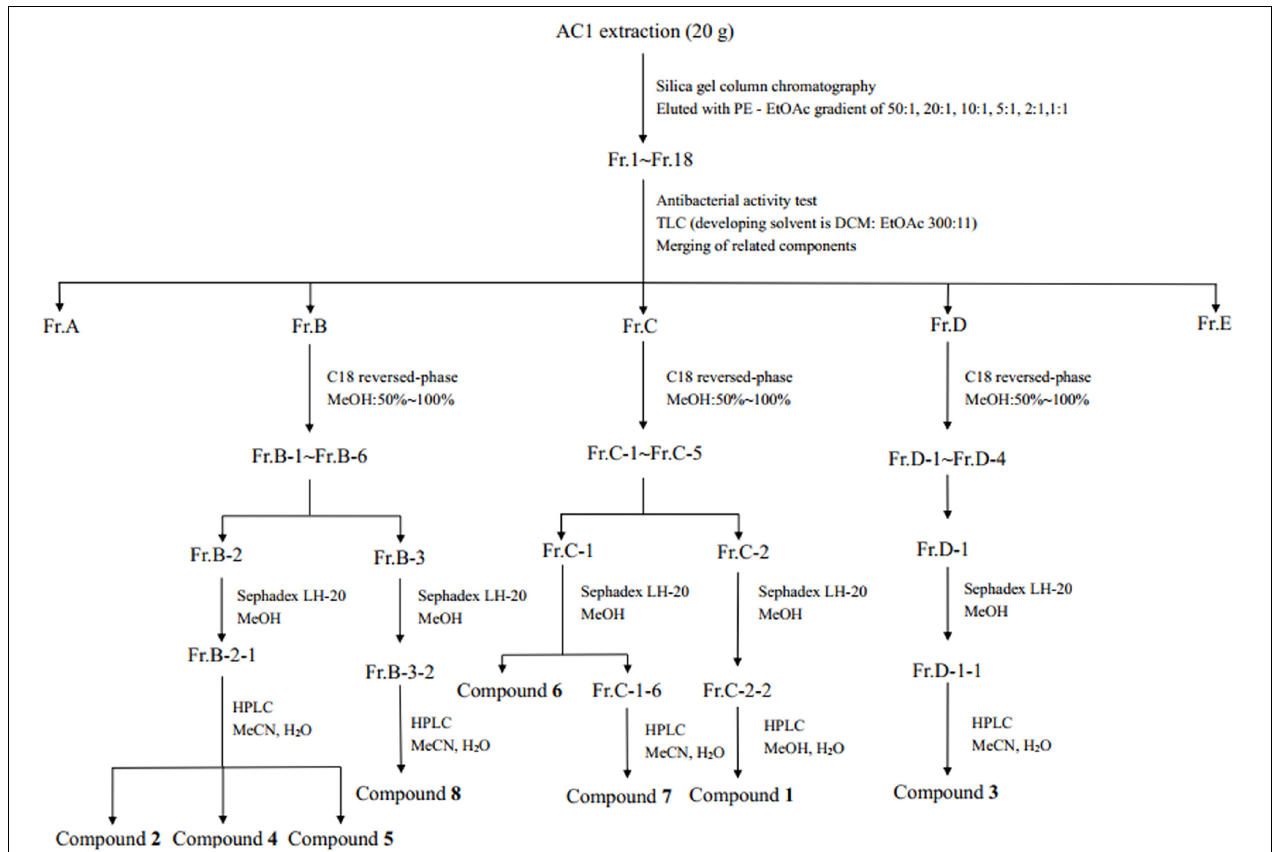
FIGURE 1 | Work up schema of the endophytic fungus strain